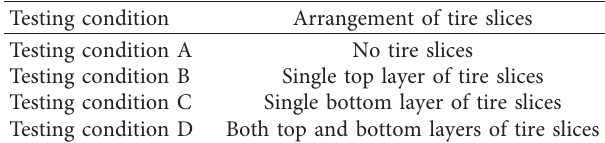
Table 1: Testing conditions.